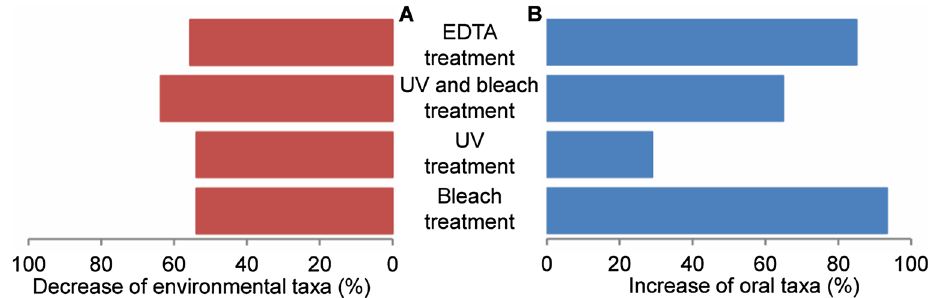
Figure 4. Percentage change in environmental and oral taxa. Taxa with significantly different abundances from the no treatment controls were identified using the G-test. Of these significant taxa, we summarized the percentage of environmental taxa (absent from HOMD) that decreased relative to the no treatment controls ( A ), and the percentage of oral OTUs (present in HOMD) that increased relative to no treatment controls ( B